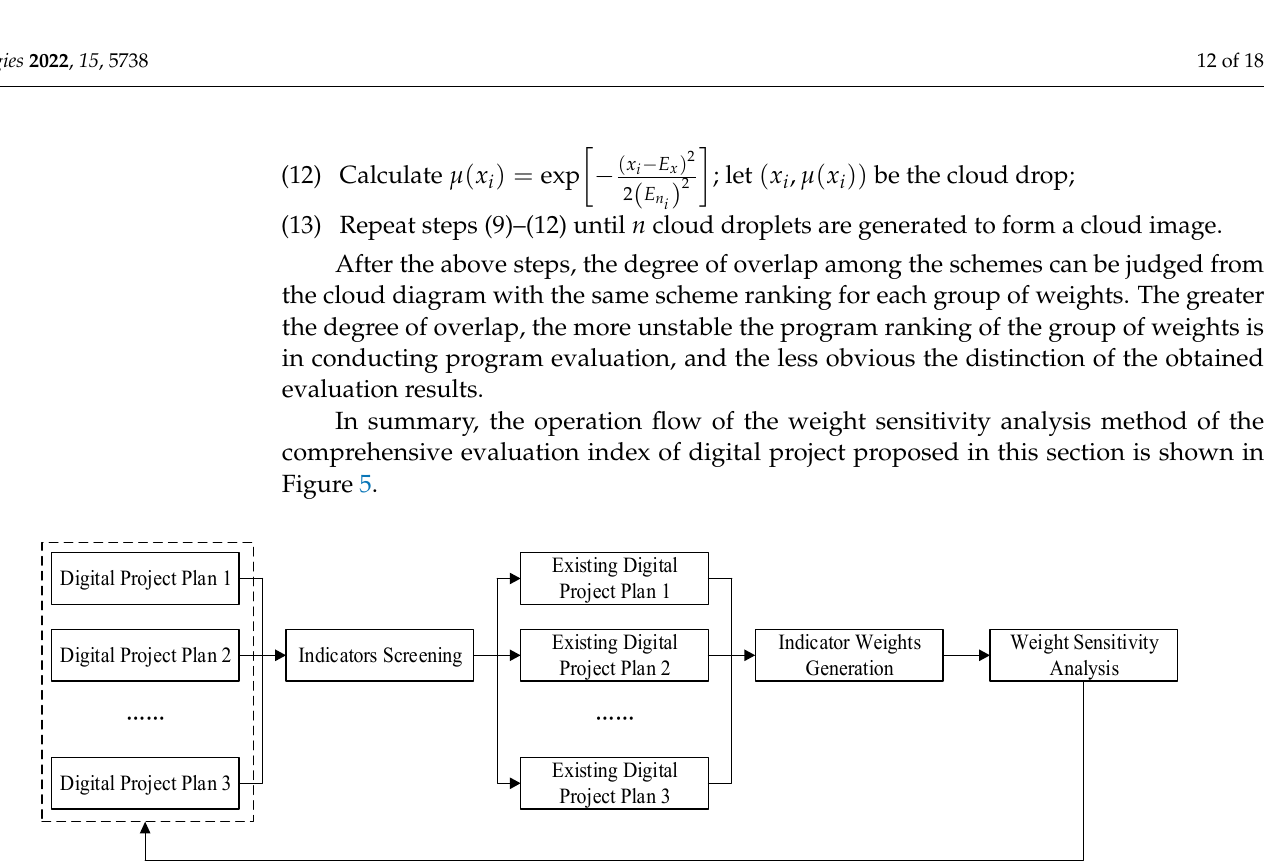
Figure 5. Process of the weight sensitivity analysis method for the comprehensive evaluation index of digital projects.